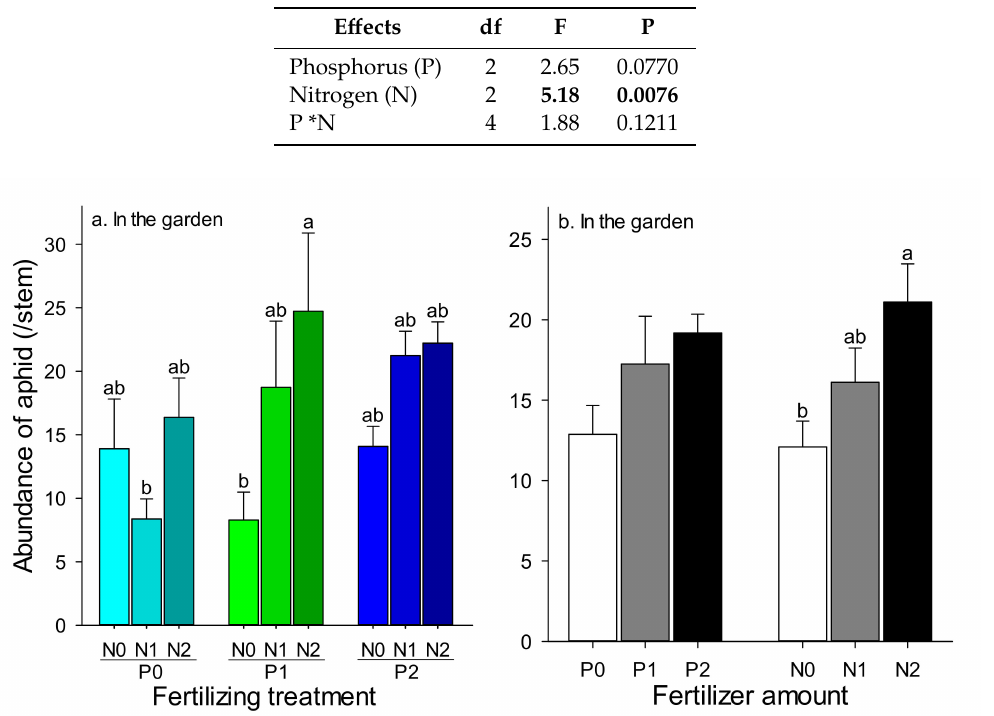
Table 3. The dependence of aphids on the amounts of phosphorus (P0, P1, P2) and nitrogen (N0, N1, N2) fertilization and their interaction in the garden. Significant results are indicated in bold.